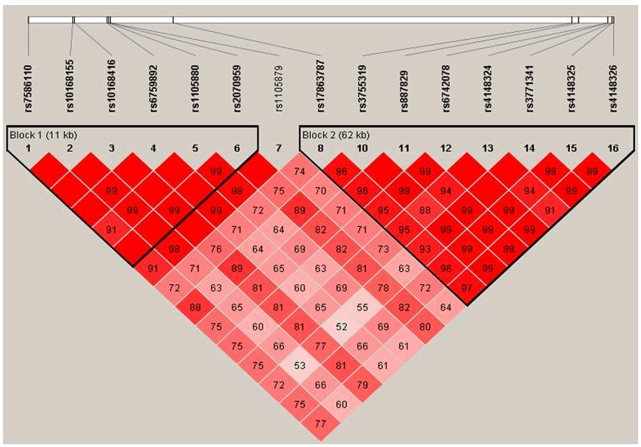
LD Structure in the CSSCD Cohort.LD plots for regions in genes UGT1A1, UGT1A3, UGT1A4, UGT1A5, UGT1A6, UGT1A7, UGT1A8, UGT1A9 and UGT1A10 on chromosome 2 in the CSSCD subjects. The LD plot was generated using Haploview 4.2. Each diamond represents the D’ value between two SNPs. The LD color scheme is: white D’<1 and LOD<2, blue D’ = 1 and LOD<2; shades of pinkish-red D’<1 and LOD≥2 and bright red D’ = 1 and LOD≥2.